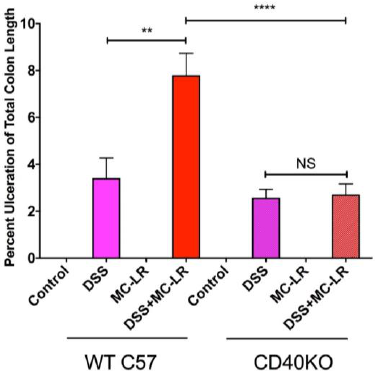
Figure 4. E ff ect of DSS and MC-LR on colonic ulceration. Total ulcer length throughout the colon was normalized to total colon length. Data presented indicate the mean ± SEM ( n = 6–11 mice per group). ** p < 0.01 and **** p <